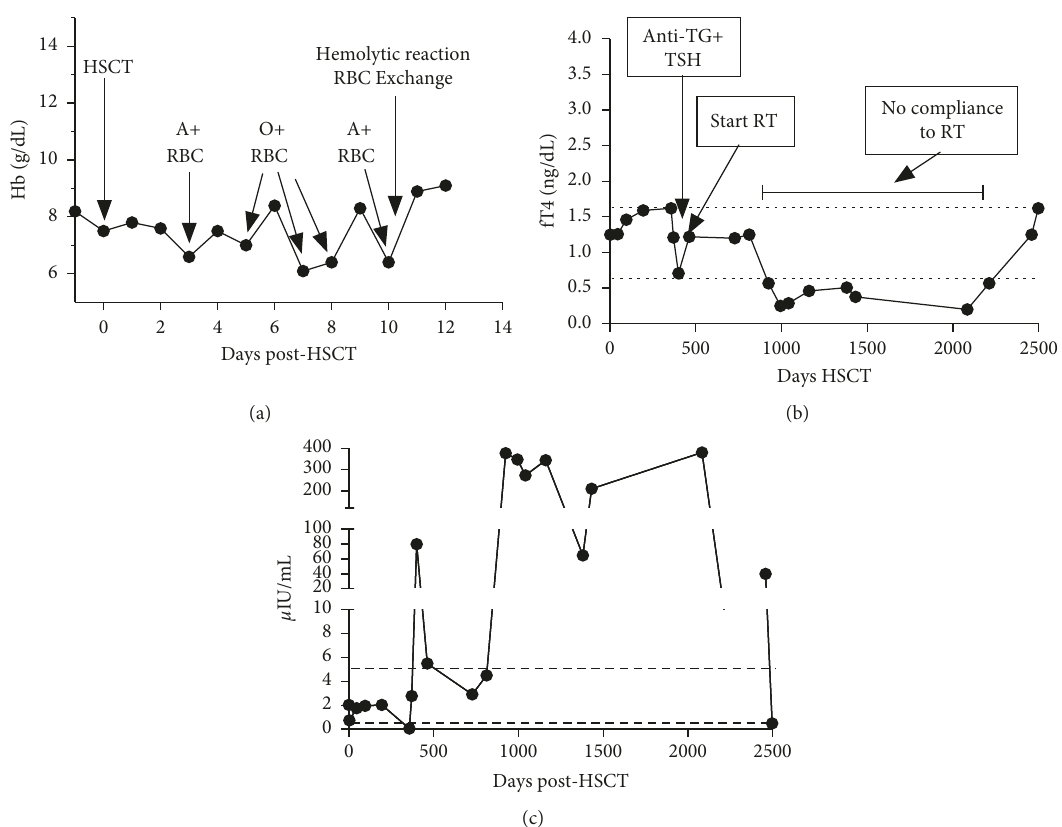
Figure 1: Onset of severe immune hemolysis and autoimmune thyroiditis in a HSCT recipient. (a): Hemoglobin level and timeline of red blood cell (RBC) transfusions up to day +12 after HSCT. Note that a severe hemolytic transfusion reaction occurred after transfusion of group A iRBCs on day +10, which prompted an emergent red blood cell exchange. (b): Free-T4 (fT4) and (c) thyroid-stimulating hormone (TSH) levels up to day +2500 post-HSCT. Note the appearance of antithyroglobulin (Anti-TG) in the serum followed by the peak of TSH and the drop of fT4, indicating autoimmune